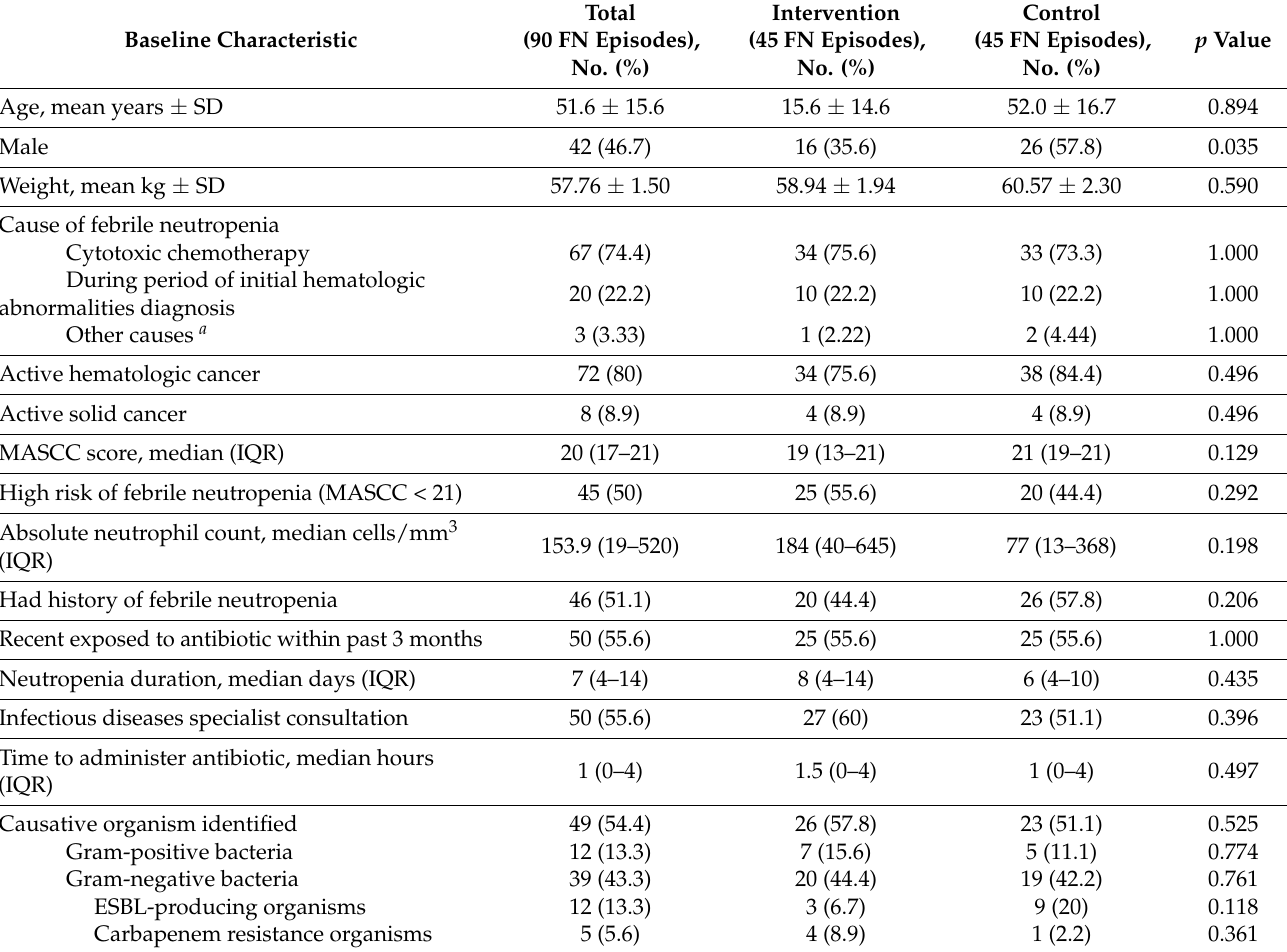
Table 1. Baseline